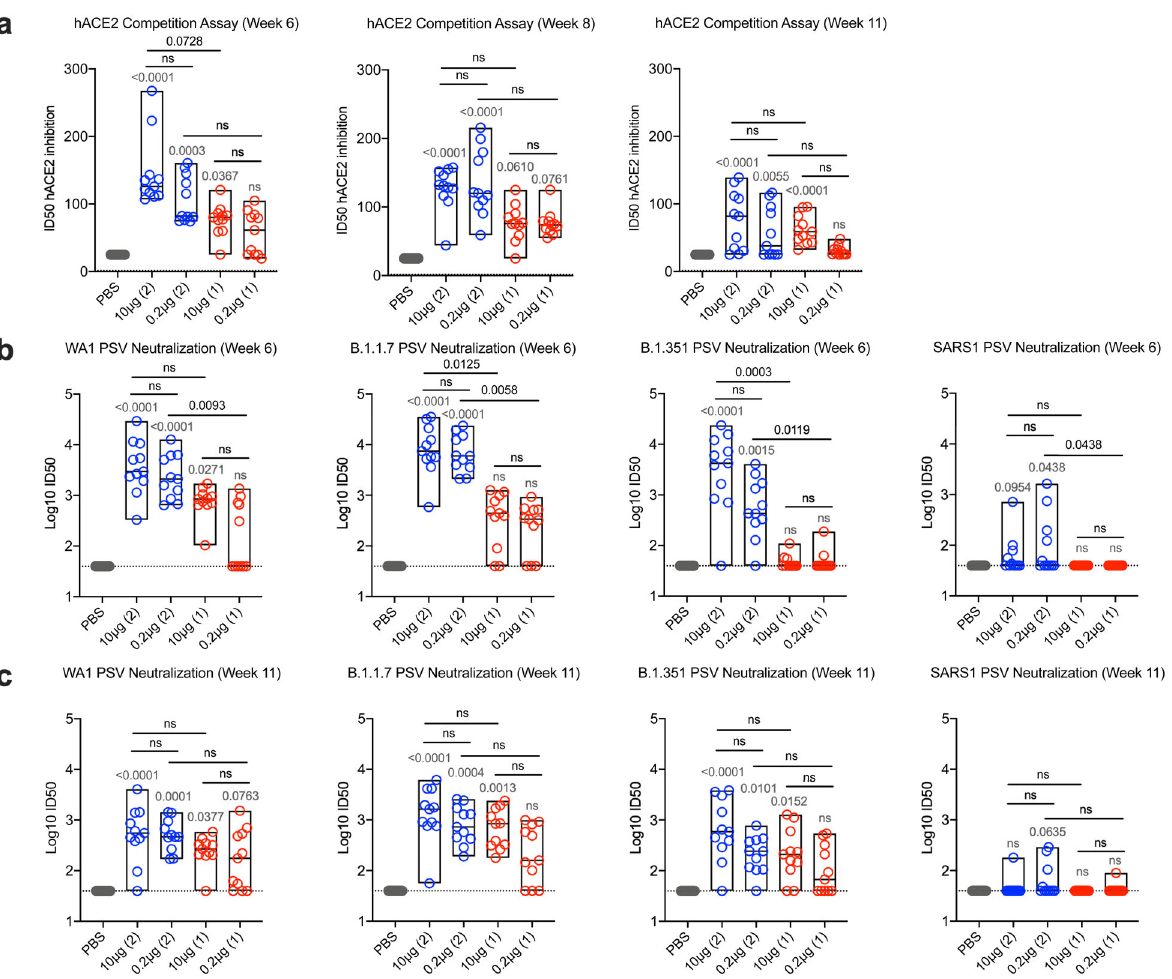
Fig. 2 Human angiotensin-converting enzyme competition and pseudovirus neutralization responses following SpFN-ALFQ immuniza- tion. a Human angiotensin-converting enzyme competition (hACE2) assays were performed from sera taken at week 6, 8, and 11. The vaccine regimens are indicated on the x -axis by PBS (control) or SpFN-ALFQ concentration with the number of vaccinations in the regimen given parenthetically and by color code (blue, 2-dose, red, 1-dose). Inhibitory dose 50% (ID50) are given on the y -axis. b , c Pseudovirus neutralization at weeks 6 and 11 are given against Spike proteins derived from WA1, B.1.1.7, B.1.351 SARS-CoV-2 variants and from SARS-CoV-1. The neutralization titers are given as inhibitory dose 50% (ID50) on the y -axis in logarithmic scale. Box plot bounds depict the standard deviation and the center line the median value. p -values for SpFN-ALFQ vaccination groups compared with PBS control are given just above the boxes in light gray while intra-active regimen p -values are given above the boxes in black. ns not signi fi cant ( p > 0.05) using the Kruskal – Wallis multiple comparisons test, with Dunn ’ s